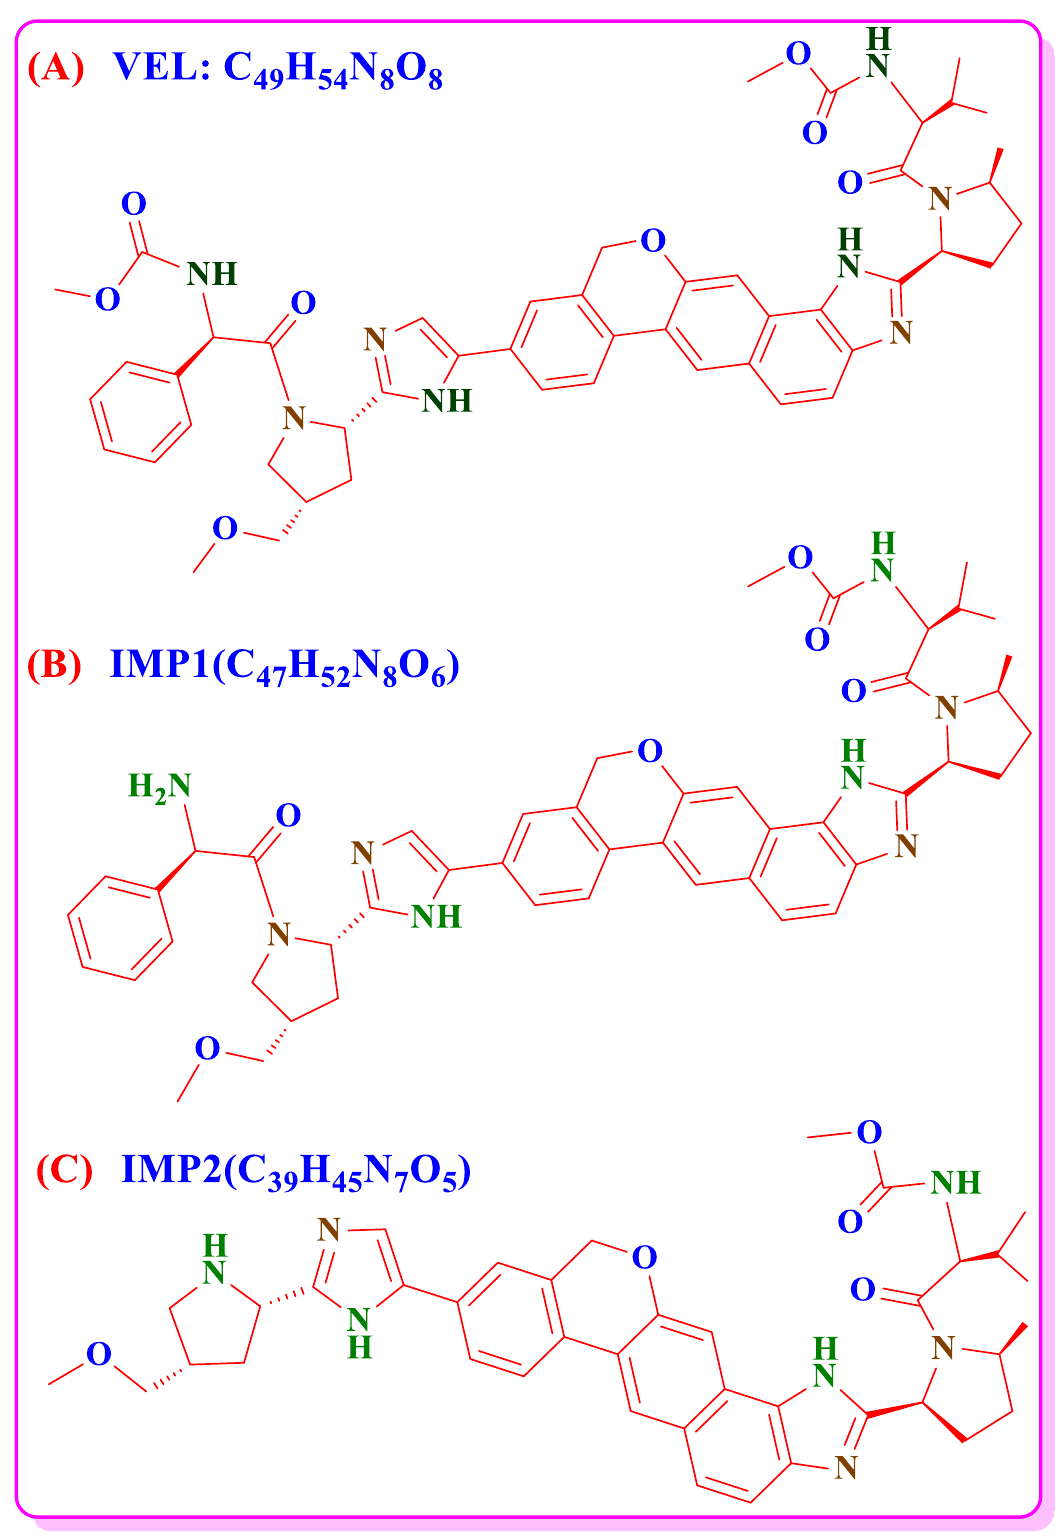
Figure 1. Chemical structures of ( A ) VEL, ( B ) process IMP-1 and ( C ) process IMP-2.